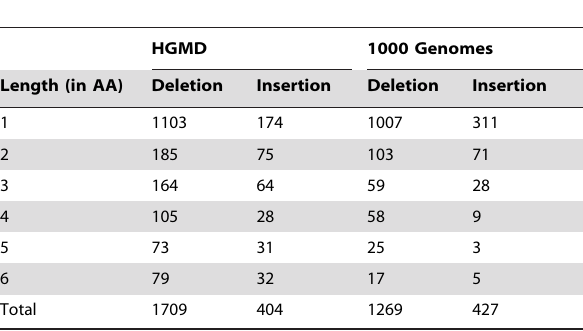
Table 4. Number of deletions and insertions collected from the Human Gene Mutation Database and the 1000 Genomes Project and used for validation of PROVEAN.